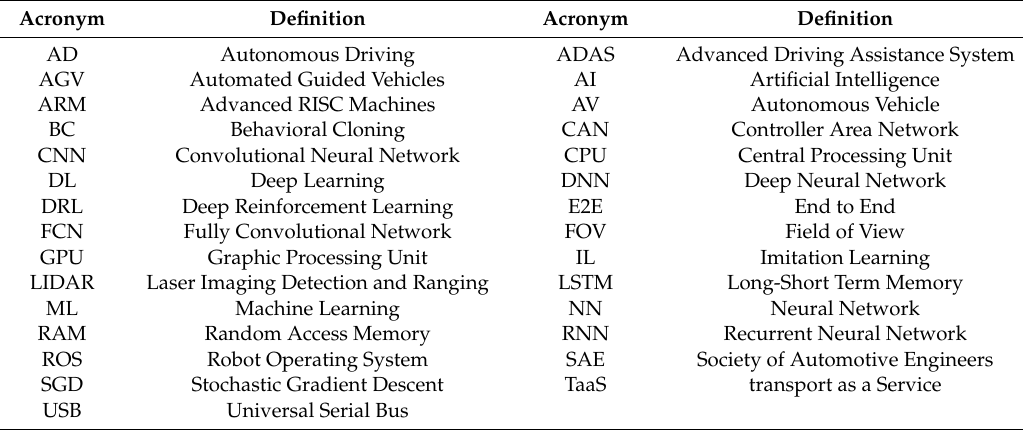
Table A1. List of